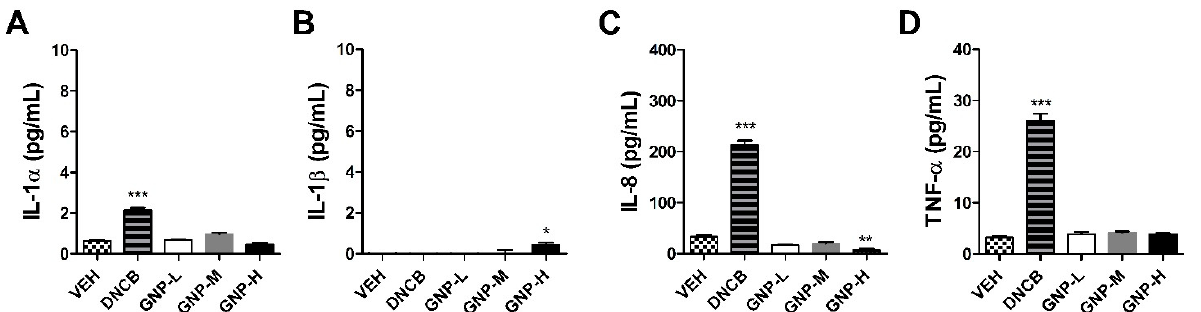
Figure 3. Expression of inflammatory cytokine in the KeratinoSens TM cells treated with the GNPs. The parameters were as follows: ( A ) IL-1alpha, ( B ) IL-1beta, ( C ) IL-8, and ( D ) tumor necrosis factor (TNF)-alpha (VEH = vehicle control, Low-dose = 500 µ M, Mid-dose = 1000 µ M, High-dose = 2000 µ M). Data are expressed as mean ± SEM values ( n = 4). Each treatment group was compared with the vehicle control group to determine statistical significance. * p < 0.05; ** p < 0.005; *** p < 0.0001.